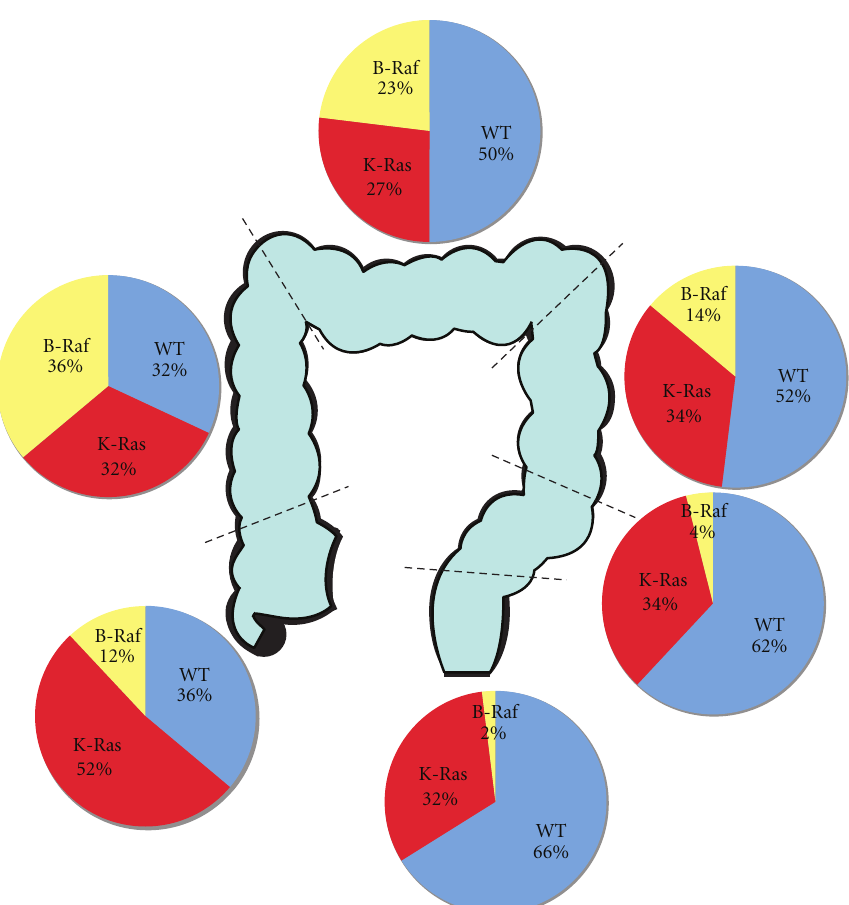
Figure 3: Incidence of K-Ras and B-Raf mutations by primary tumour site (data from Yamauchi et al.